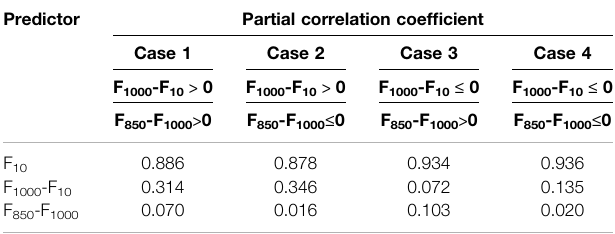
TABLE 1| Partialcorrelationcoef fi cients offorecast factors under differentvertical wind shear conditions from 2017 to 2019. Predictor